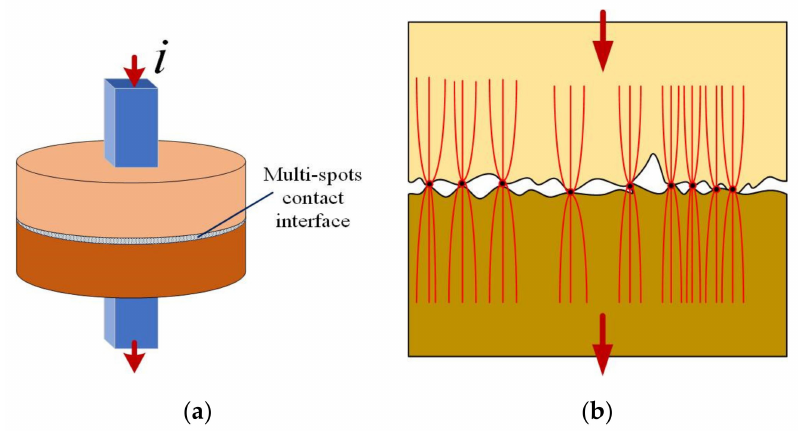
Figure 5. Schematic view of the contact configuration: ( a ) copper disks in contact; ( b ) constriction of the current lines flowing through the multiple contact